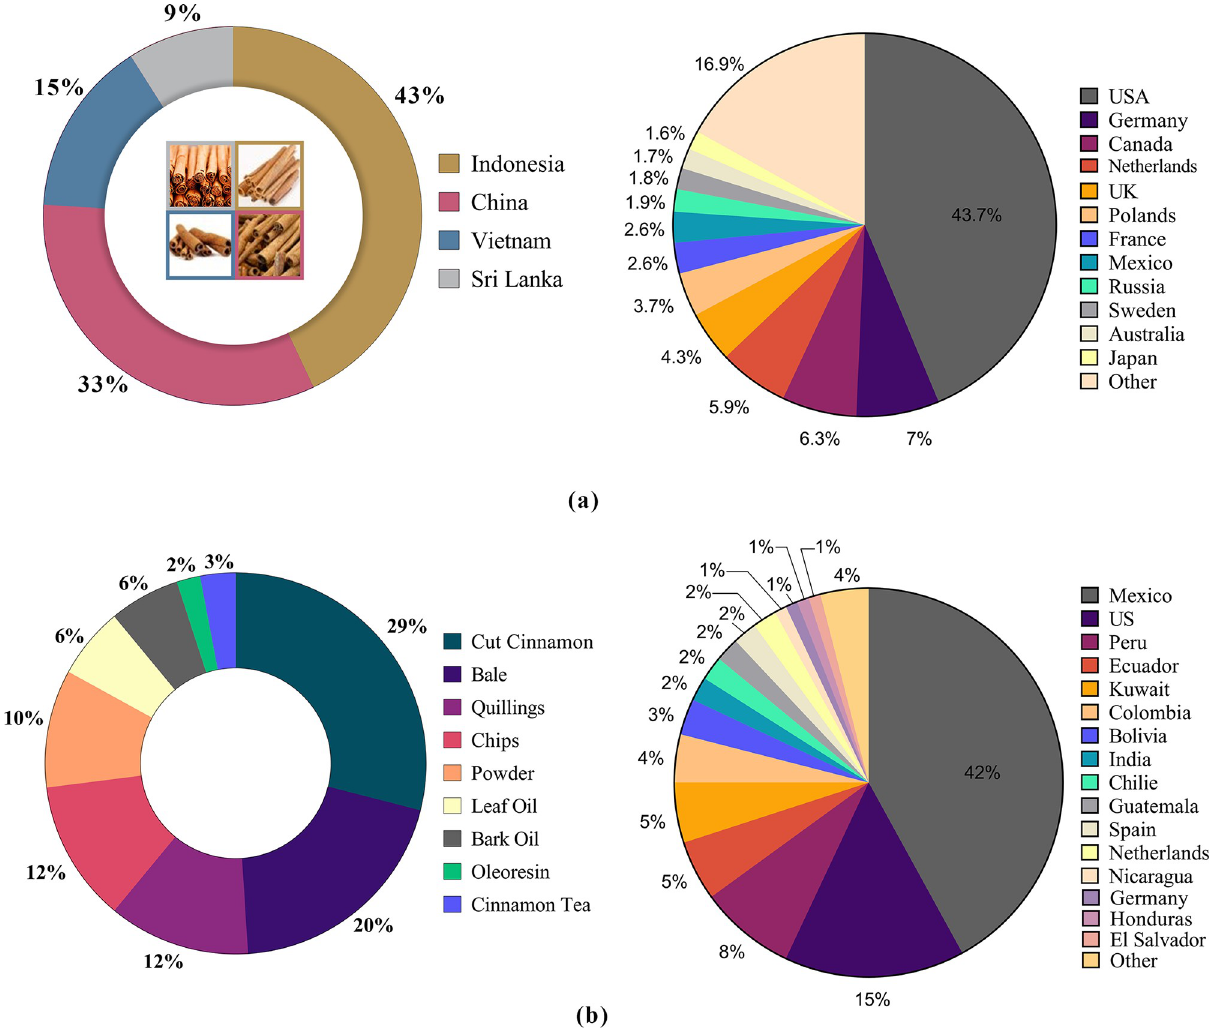
Fig 1. Cinnamon market share & types. (A): Market share (%) of the leading global cinnamon exporters & importers. Indonesia, holds the highest export market share, leads the global cinnamon exports followed by China. Sri Lanka, 4 th largest supplier to the world cinnamon market while act as the leading supplier of true cinnamon (82%). USA dominated the cinnamon imports by placing the EU, historical leader into second place. (B): Composition of Ceylon cinnamon export basket & export destinations. Ceylon or true cinnamon exports cater both residential and commercial market segments globally. Mexico has emerged as one of the leading consumers of Ceylon cinnamon together with Latin America placing USA and EU into second